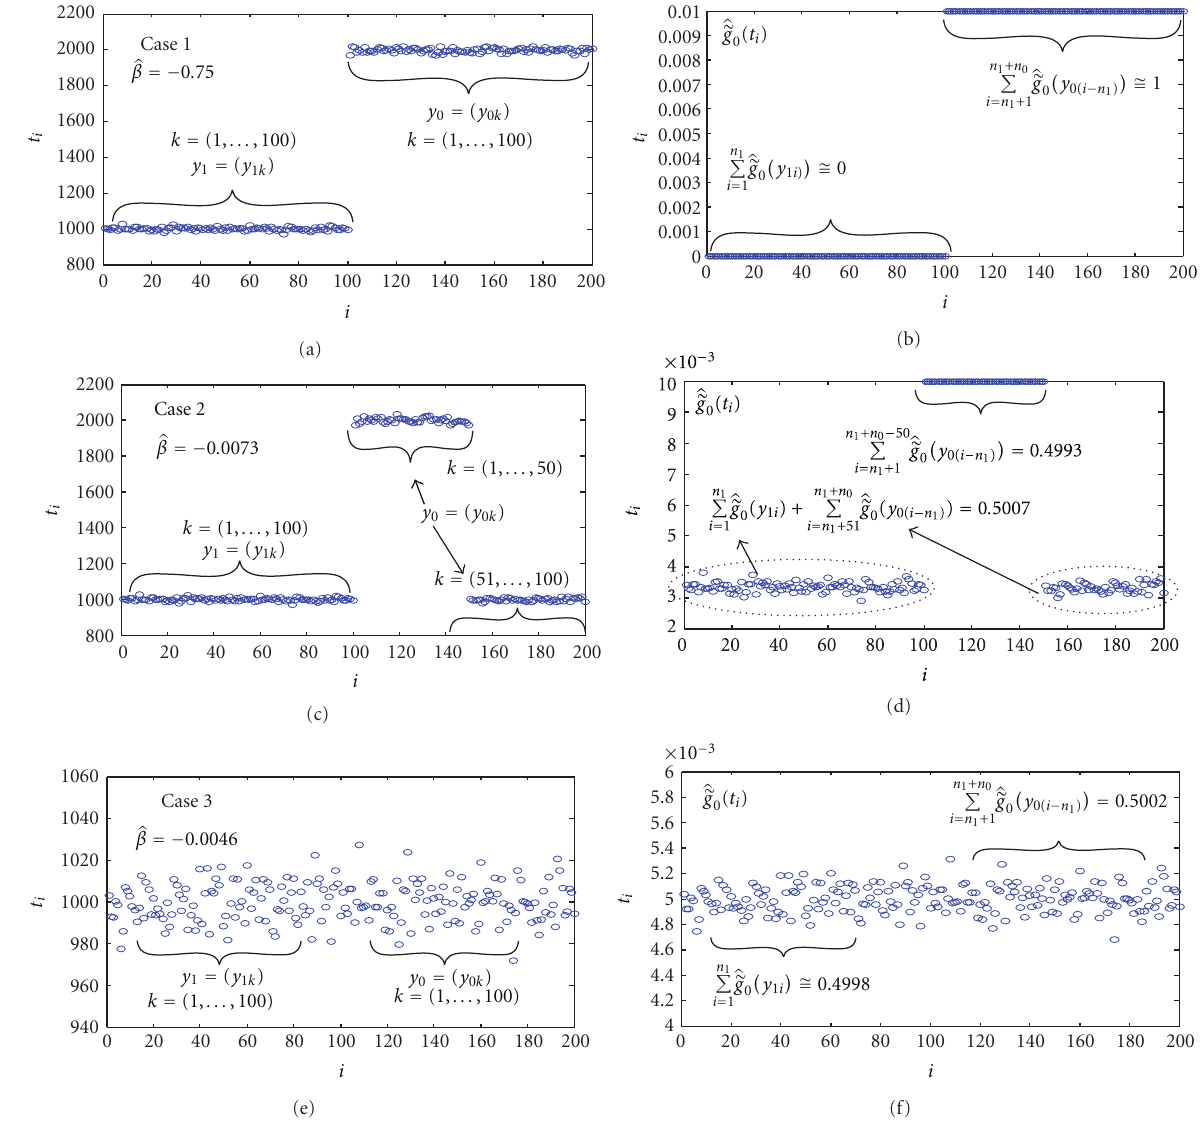
Figure 6: E ff ect of estimators (cid:29) α , (cid:29) β on the computation of (cid:29)(cid:23) g